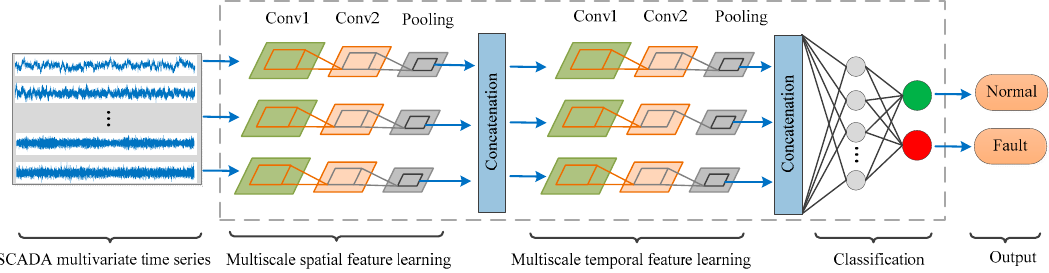
Figure 2. Schematic of the developed multiscale spatio-temporal convolutional deep belief network (MSTCDBN) method.